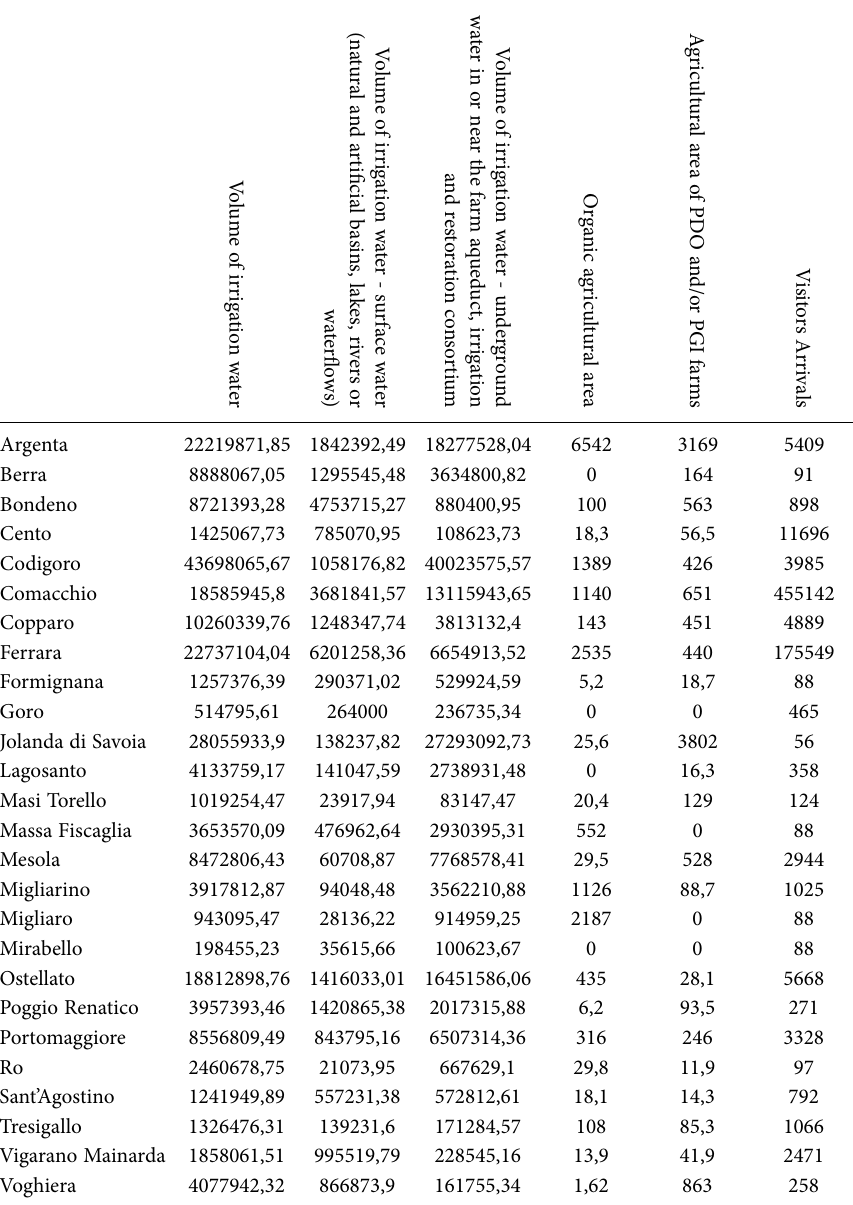
Table A1. Ecosystem services provision